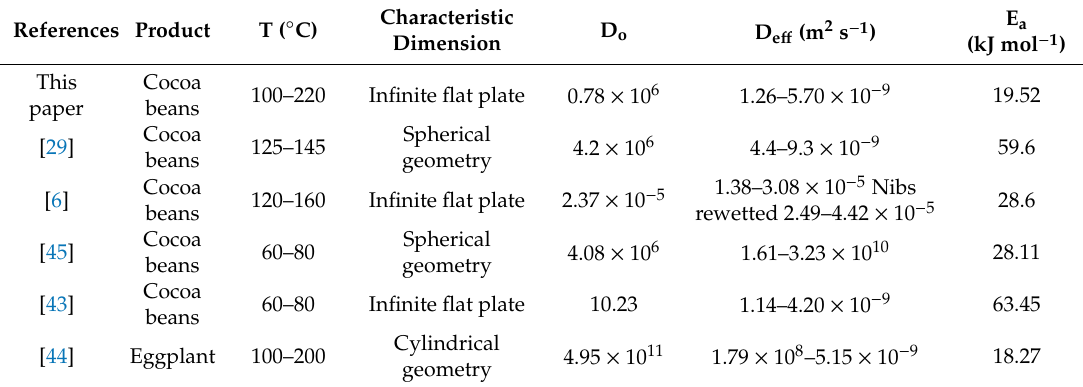
Table 6. Di ff usivity data and activation energy for cocoa beans during di ff erent dehydration Table 6. Diffusivity data and activation energy for cocoa beans during different dehydration processes.